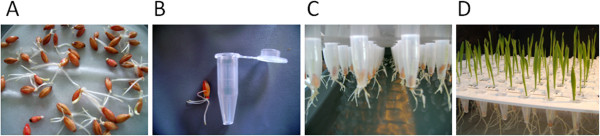
Seed germination and plant cultivation. A. Barley seeds were germinated in the dark at room temperature. B. After 72 h, seedlings that had three to five roots of 1.5 to 2.0 cm length and that had not yet started to extend the shoot were selected. Each seedling was inserted into a 1.5 ml reaction tube (Eppendorf, Hamburg) that was cropped at the bottom. C. The tubes with the seedlings were subsequently plugged into the perforated trays and placed on top of the boxes. D. Throughout the experiments the roots plunged into the nutrient solution whereas plant shoots grew on top of the tray.